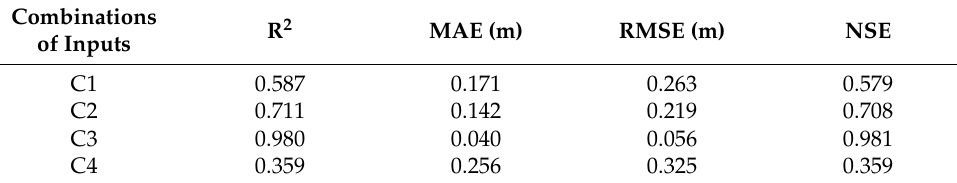
Table 4. Training performances of river stage forecasting using SVR with four input combinations.